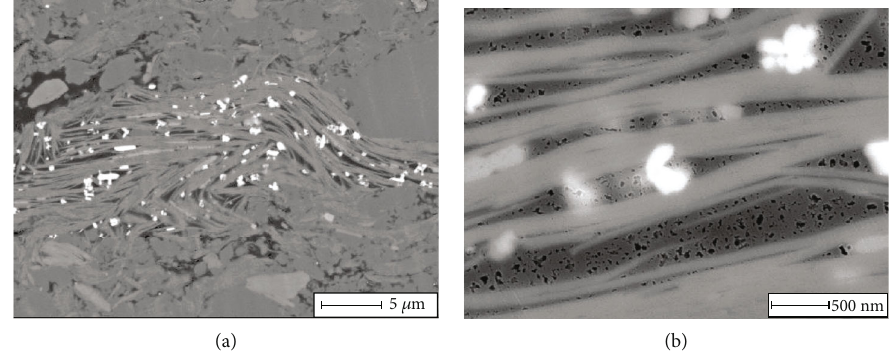
Figure 12: Pyrobitumen in the clay mineral layers, with pores mainly smaller than 50